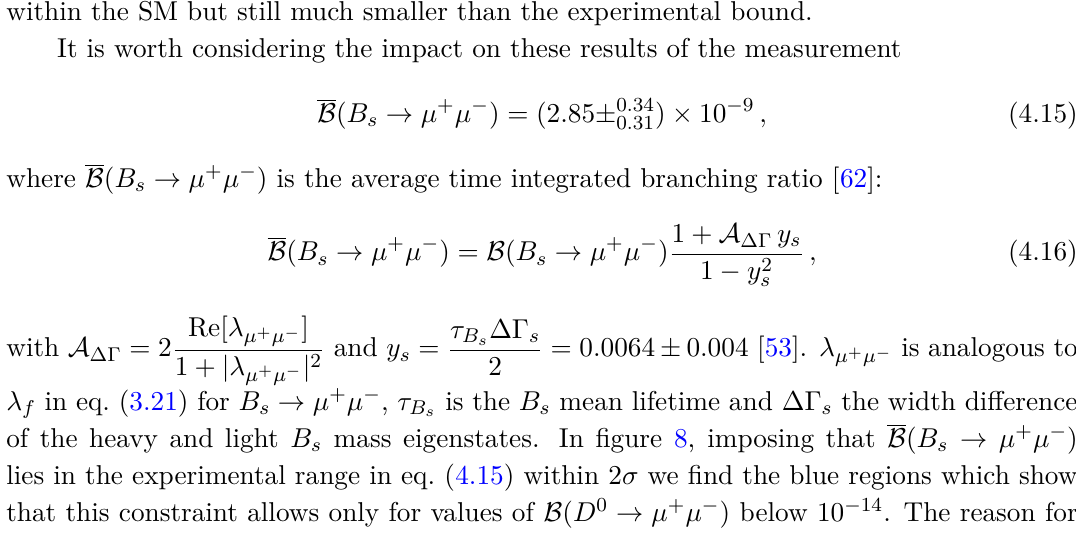
JHEP10(2021)021